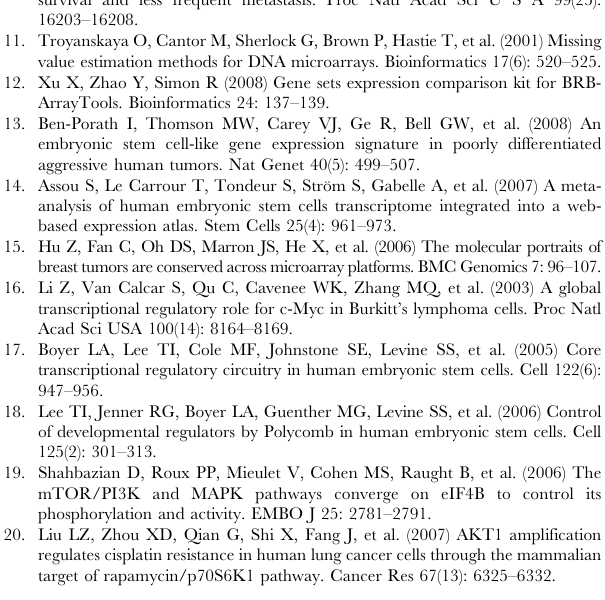
Table S1 Characteristics of Healthy Volunteers. Table S2 Quality Control Parameters of Microarray Data for Patient Subsets Used for the Analyses. Table S3 A Functional Category Significantly Enriched in Upregulated Genes in the Acquired Resistance ( P for Feature Selection , 0.01) according to the Ingenuity Pathway Analysis. Table S4 Transcription Factor Target Gene Lists Which Have More Genes Differentially Expressed between Pretreatment and the Acquired Resistance State than Expected by Chance. Table S5 LS P Values for Gene Comparison Analyses for Various Ranked Gene Lists of the BRB-ArrayTools Projects Using Published Stem Cell-related Gene Sets as User-defined Gene Sets. Table S6 Gene Comparison Analyses for Acquired Resistance Signature 1 Using Published Stem Cell Genesets as User-defined